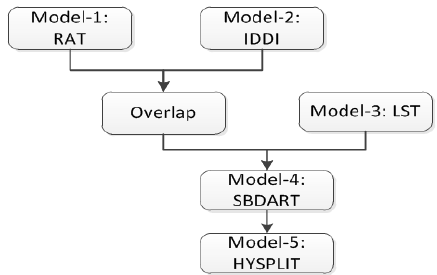
Figure 4. Workflow of the integrated dust storm detection